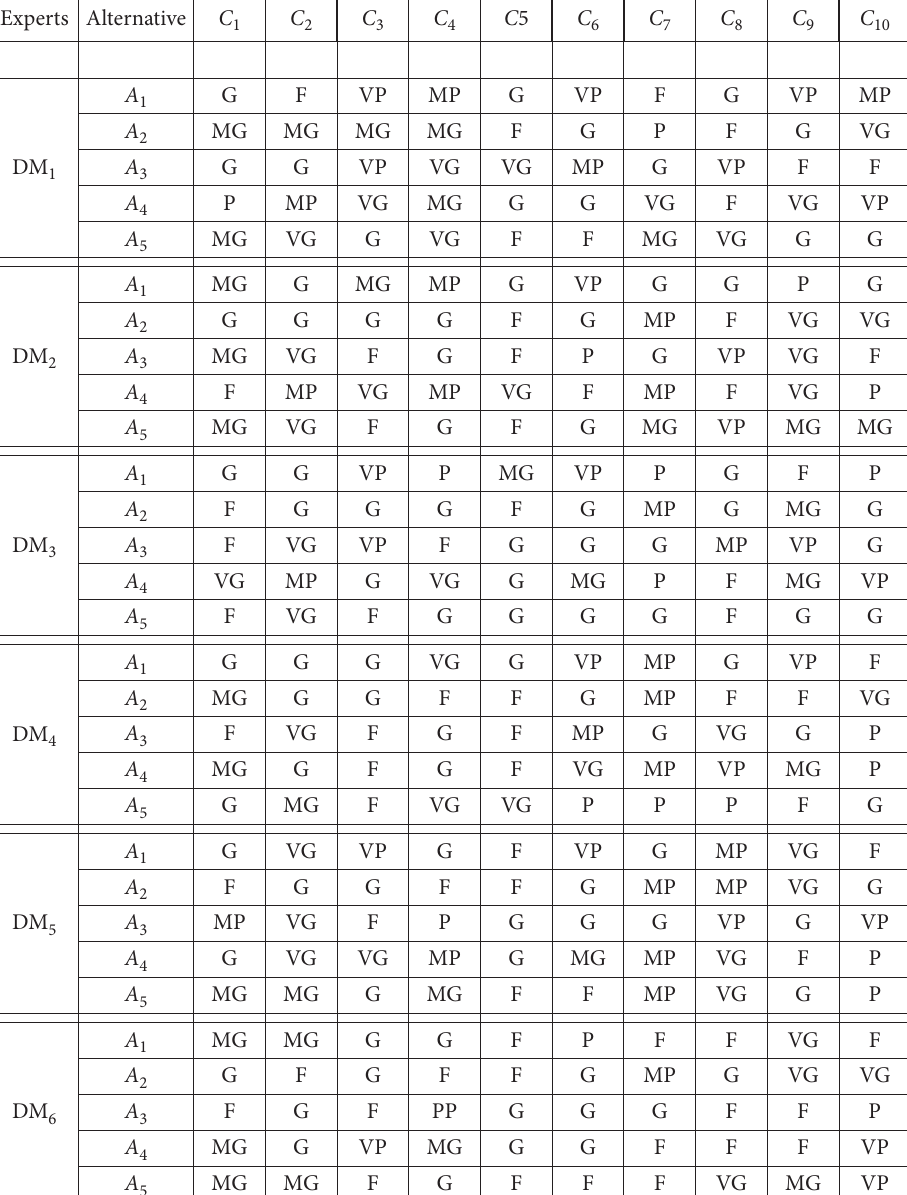
Table 7. Attribute rating values for supplier alternatives considering different experts decision Experts Alternative C 1 C 2 C 3 C 4 C